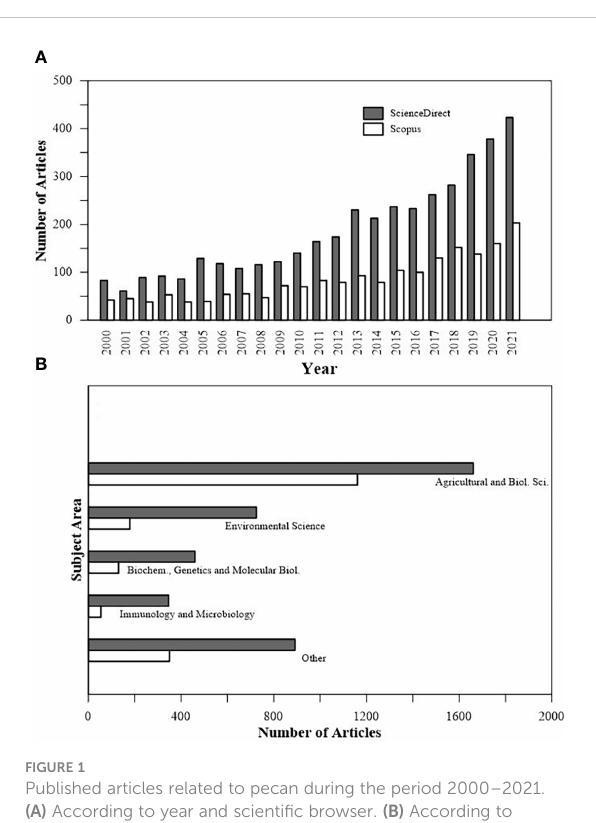
FIGURE 1 Published articles related to pecan during the period 2000 –